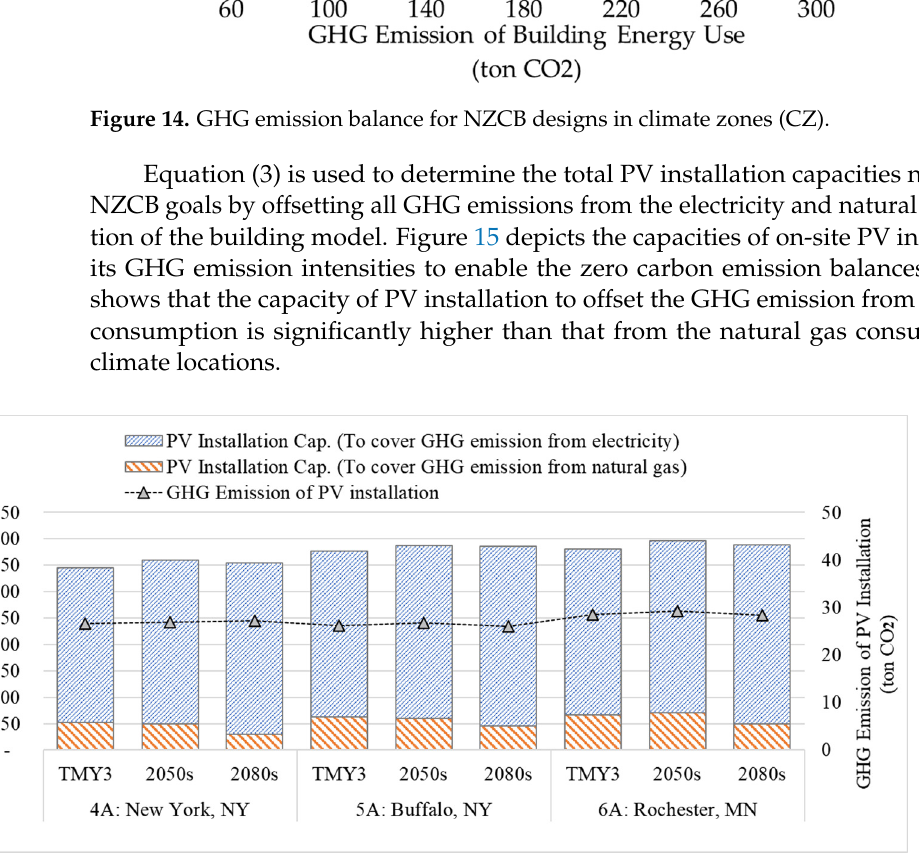
Figure 15. PV installation capacity and its GHG emission intensity to enable NZCBs.